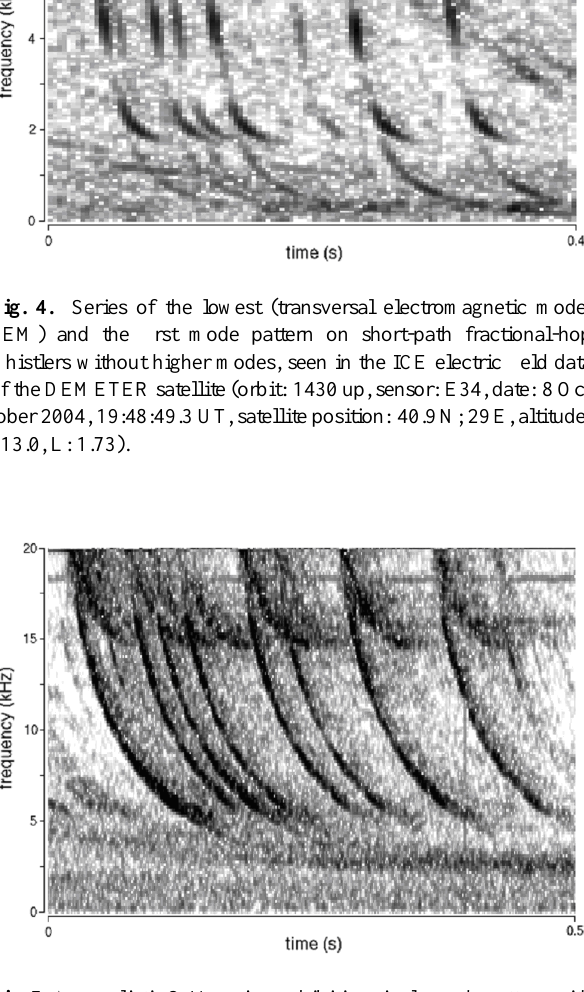
sort of branching can be explained as a single guided mode, leaking out of the EIWG, together with the fractional-hop whistler, or formed during the ionospheric traverse. The lat- ter scene assumes a mode-dependent (mode-selecting) out- coupling mechanism for the VLF impulses in the lower plas- masphere or at the lower boundary of the ionosphere. Simi- larly to other fractional-hop whistlers, SpW signals are often seen together with ion-whistlers, propagated contemporane-